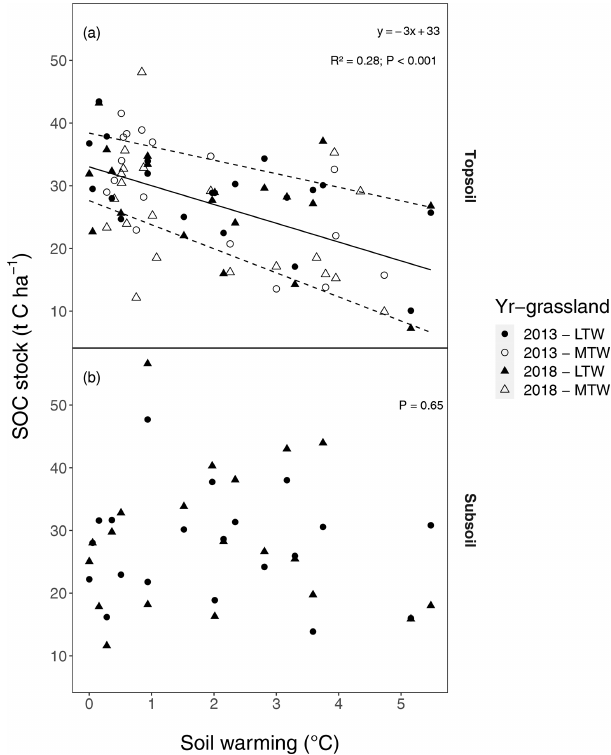
Figure 1. Soil organic carbon (SOC) stocks (tCha − 1 ) along soil warming gradients, (a) in the topsoil (0–10cm) and (b) in the sub- soil (10–30cm) after a soil mass correction. The regression (solid line; dashed lines represent the 95% confidence interval; regression details provided in the inset) for medium-term warmed (MTW) and that for long-term warmed (LTW) grassland (in topsoil) for both 2013 and 2018 were combined, since neither a soil temperature– warming duration interaction effect nor a main effect for warming duration or sampling year was found. For topsoil, the marginal R 2 from the linear mixed-effects model is shown. The soil mass cor- rection is visualised in Fig. B8, and an explicit model description can be found in Appendix A “Material and methods”. The uncor- rected SOC stocks yield qualitatively similar conclusions (Fig. B1), as does the C percentage in topsoil and subsoil (Fig. B2). ( n = 78 and n = 40 for topsoil and subsoil